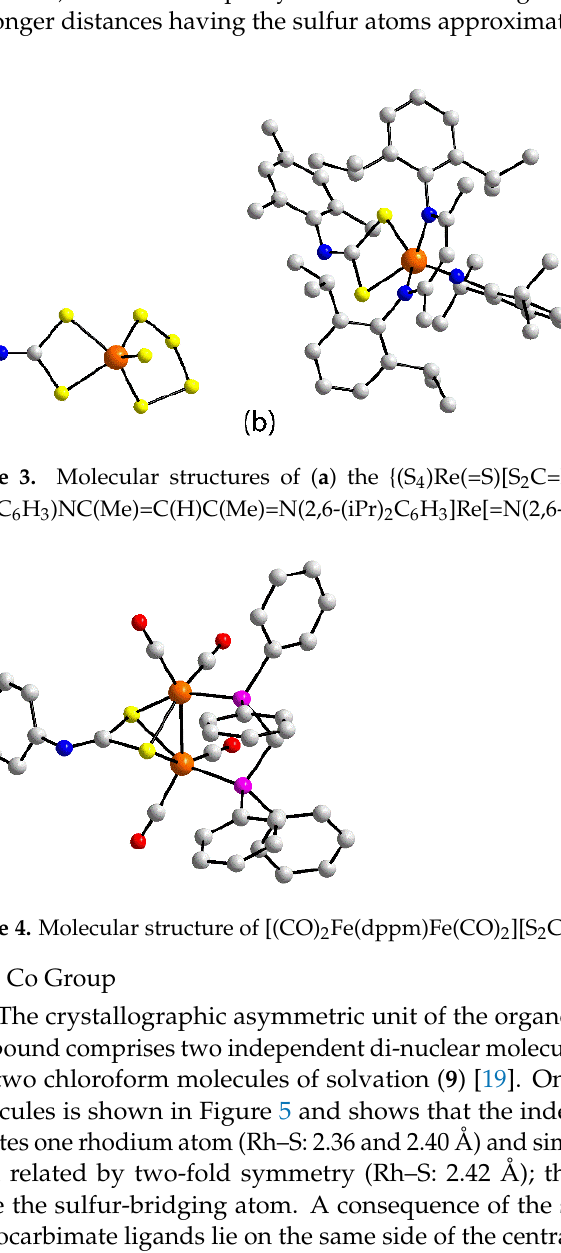
Figure 3. Molecular structures of ( a ) the {(S 4 )Re(=S)[S 2 C=N(Me)]} − anion in 6 and ( b ) [(2,6- (iPr) 2 C 6 H 3 )NC(Me)=C(H)C(Me)=N(2,6-(iPr) 2 C 6 H 3 ]Re[=N(2,6-(iPr) 2 C 6 H 3 )][S 2 C=N(Mes)] ( 7 ).